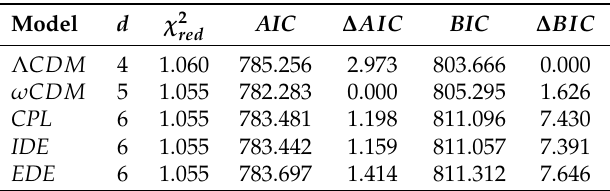
Table 6. AIC and BIC for different DE models using the combined analysis (CMB + BAO + SNIa + d A + f gass + SGL), where N = 737 and χ 2